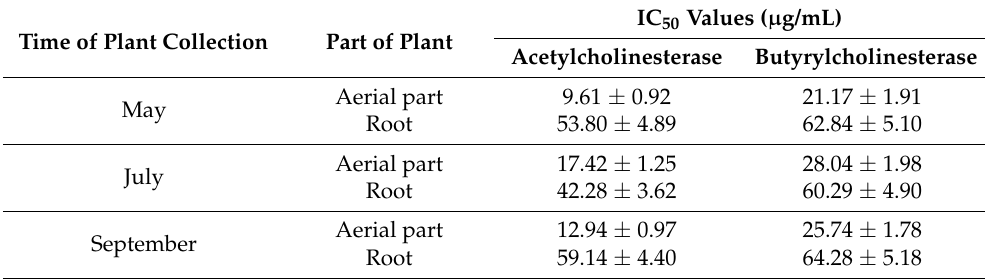
Table 4. IC 50 values obtained for plant